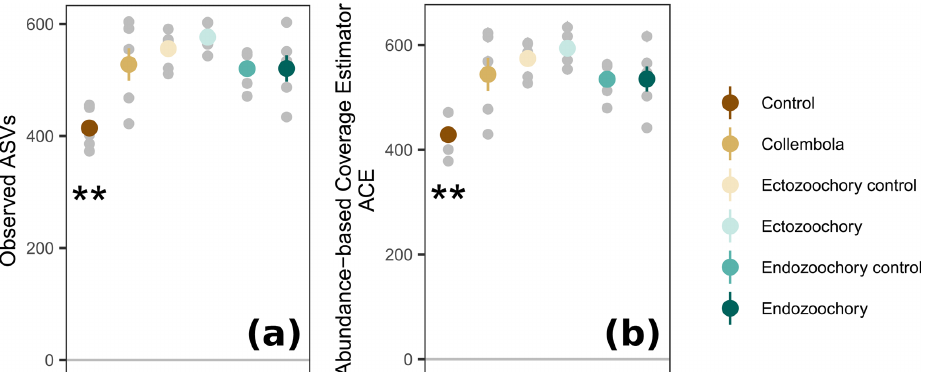
Figure 3. Response of permafrost bacterial alpha diversity to the addition of Collembola undergoing different microbiome manipulation treat- ments. (a) Number of observed ASVs (amplicon sequence variants) per sample; (b) abundance-based coverage estimator (ACE). Coloured symbols and error bars are means and standard errors within a treatment ( n = 6); small grey symbols are individual samples. Error bars are only shown when exceeding the symbols’ size. Asterisks denote that the no-Collembola control differs from all other treatments (estimated marginal means pairwise comparison, 0.001 < Holm-adjusted P <